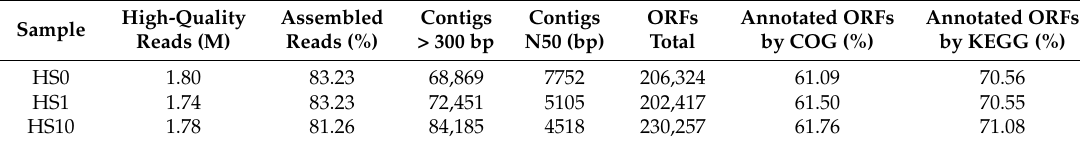
Table 1. Sequencing, assembly and annotation